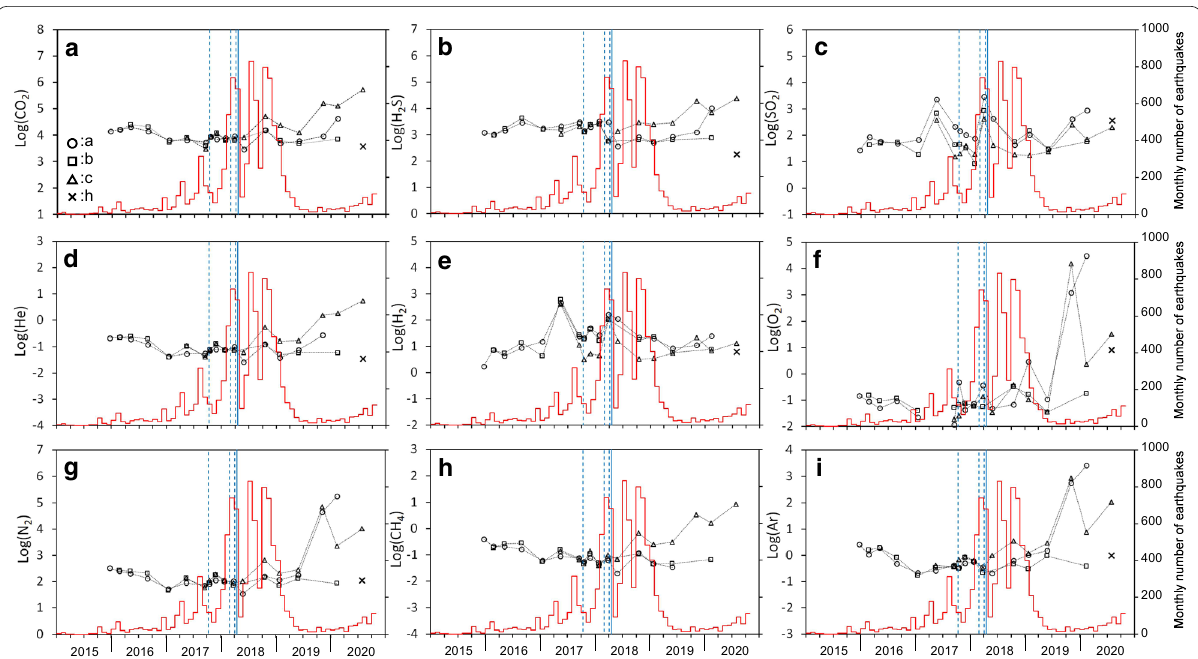
Fig. 4 Changes in the concentration of CO 2 ( a ), H 2 S ( b ), SO 2 ( c ), He ( d ), H 2 ( e ), O 2 ( f ), N 2 ( g ), CH 4 ( h ), and Ar ( i ). The vertical axis is calibrated as the logarithm of ppm (µmol/mol) concentration. Red histogram and vertical lines have the same significance as in Fig. 3